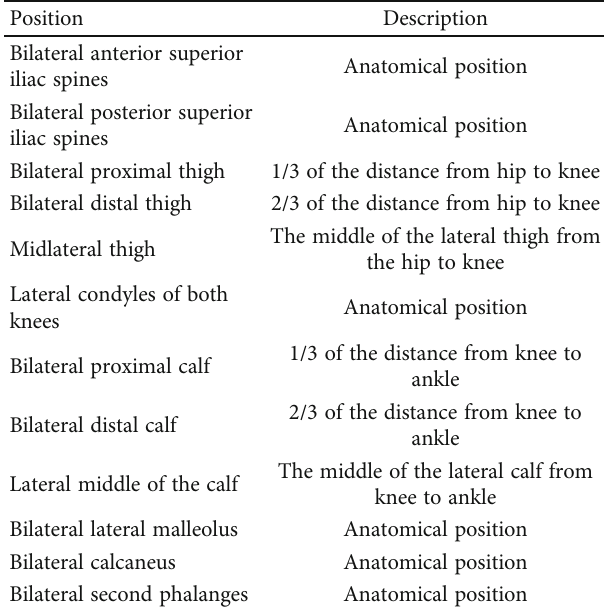
Table 1: Description of the paste position of the